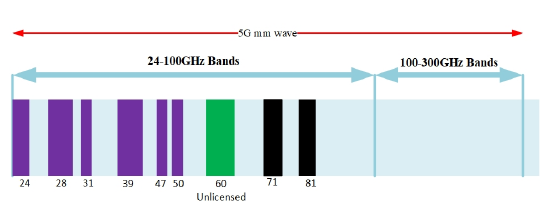
Figure 4. Available spectrums in different mm-wave bands